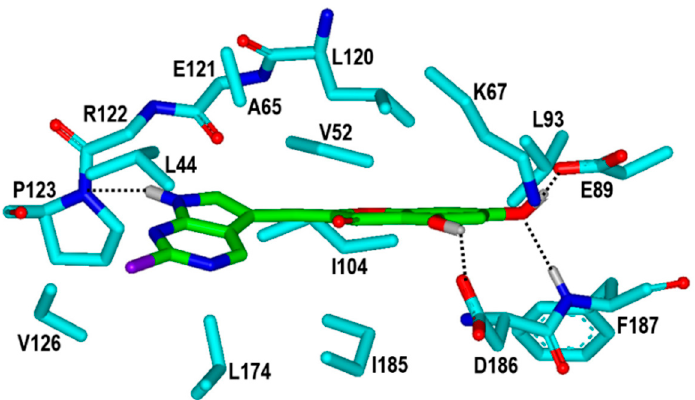
Figure 5. Calculated binding mode of 16 in the ATP-binding site of PIM1 kinase. Carbon atoms of PIM1 and 16 are indicated in cyan and green, respectively. Dotted lines indicate the hydrogen bonds.